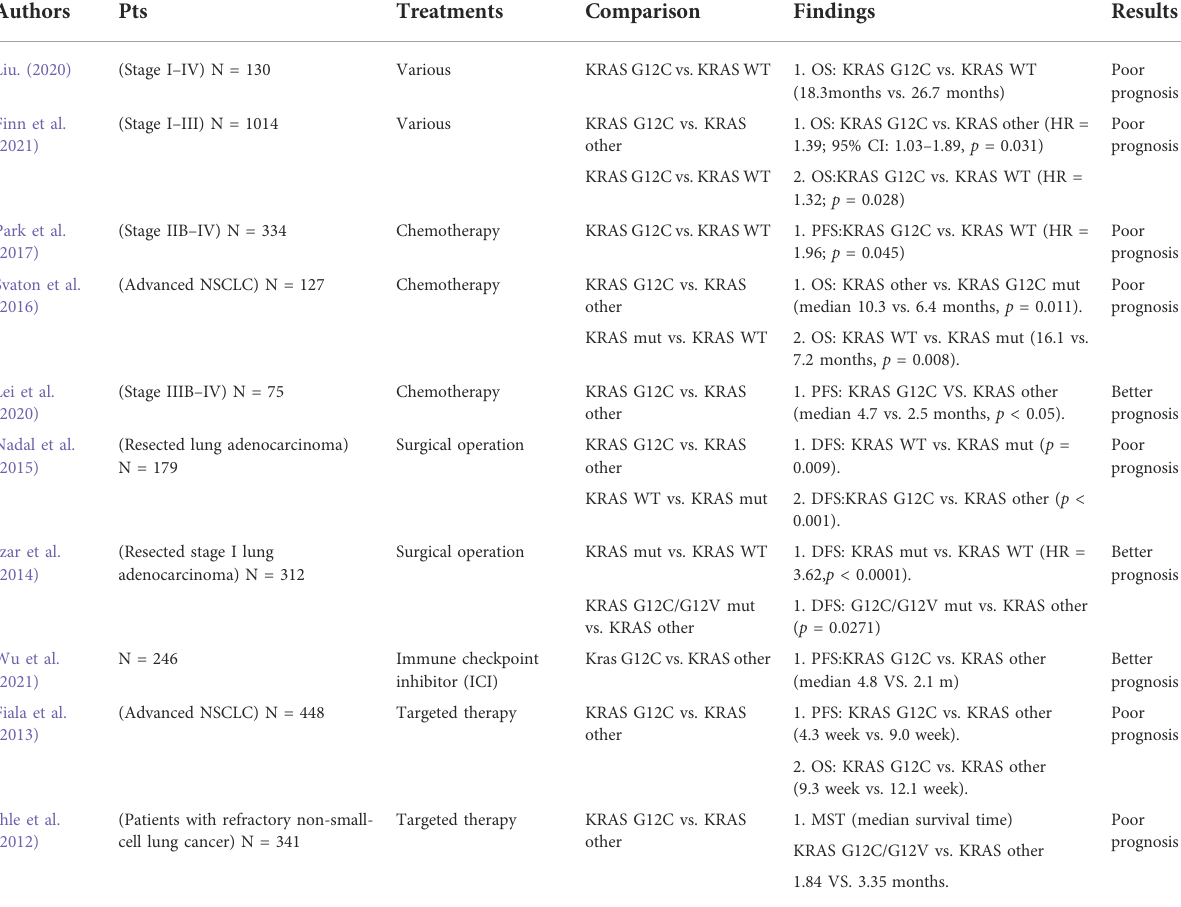
TABLE 1 Selected major studies about the prognostic relevance of KRAS G12C status in lung cancer.